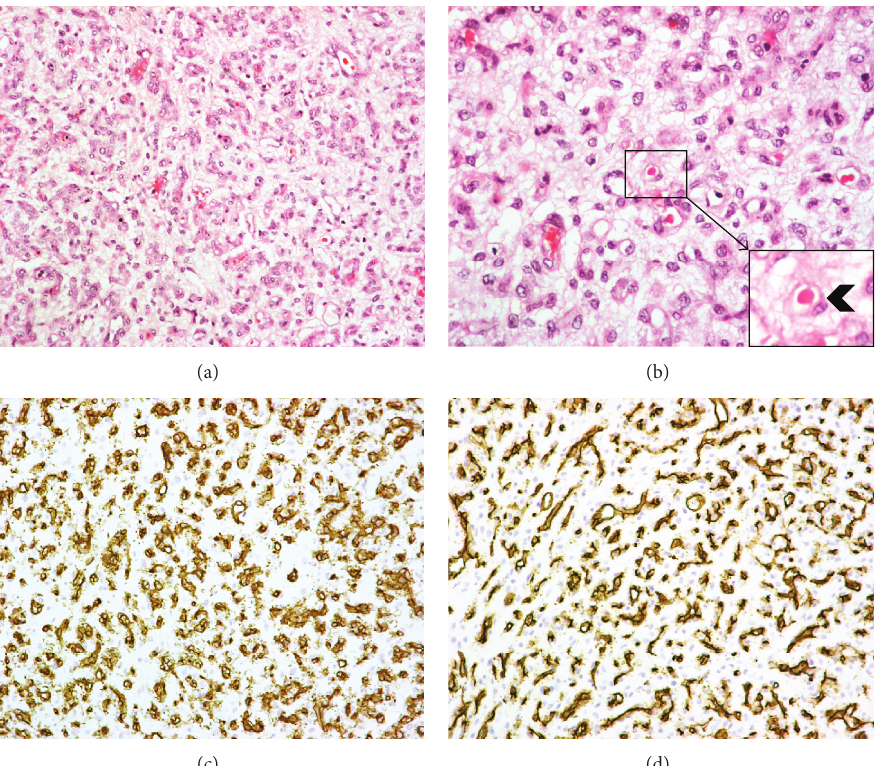
F 1: (a) and (b) tissue sections showing well-formed vascular channels embedded in a myxoid stroma. Note focal areas of abortive endothelial differentiation (hematoxylin and eosin stained sections, (a) magni�cation the presence of an intracytoplasmic vacuole containing a single erythrocyte (arrowhead) (magni�cation demonstrating strong diffuse immunoreactivity for the endothelial markers CD31 (c) and CD34 (d), magni�cation dilution 1 : 70), Cytokeratin (DAKO, clone MNF116,